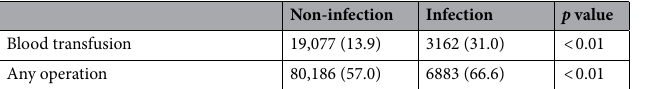
Table 1. Characteristics of trauma patients with and without infection. Continuous variables were compared using the Mann–Whitney U test. Categorical variables were compared using the Chi-square test. Missing: GCS = 13,085, SBP = 2281, HR = 5577, Temperature = 15,926, RR = 21,441, Blood transfusion = 3421. AIS Abbreviated Injury Scale, ISS Injury Severity Score, COPD chronic obstructive pulmonary disease, DM diabetes mellitus, HD hemodialysis, GCS Glasgow coma scale, SBP systolic blood pressure, HR Heart rate, RR respiratory rate, REBOA resuscitative endovascular balloon occlusion of the aorta, TAE transcatheter arterial